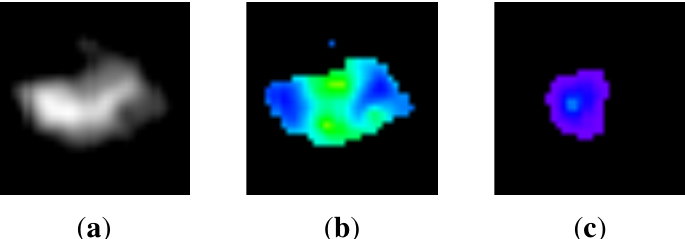
Figure 16. An example of a false negative. ( a ) An example of a large nodule. ( b ) The result of the moment-of-inertia filter. ( c ) The result of the center displacement